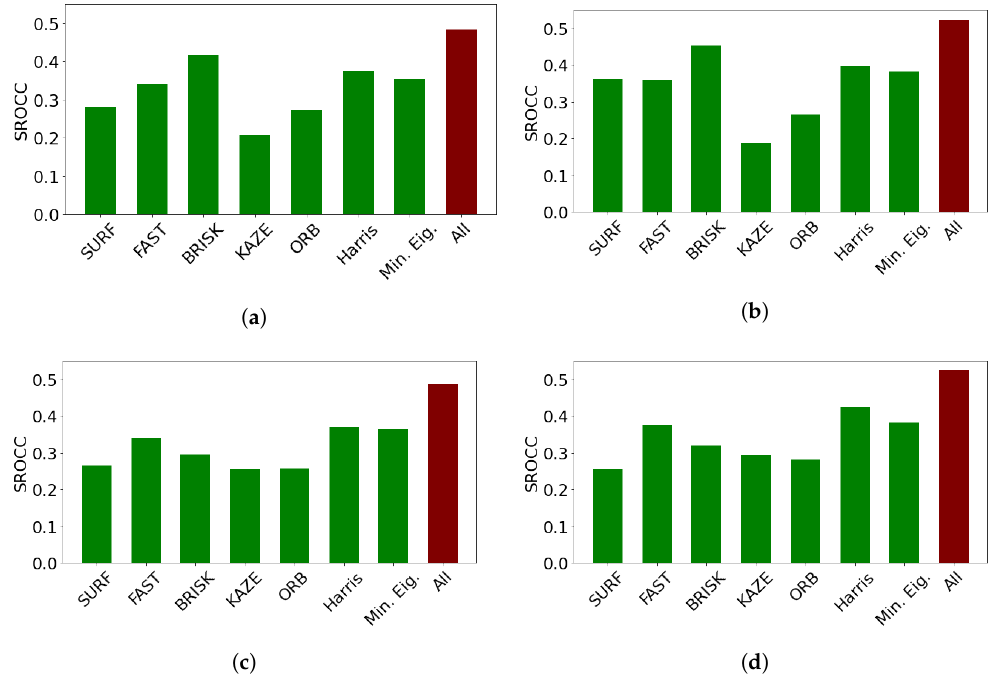
Figure 3. Comparison of the statistics of local feature descriptors as quality-aware features in CLIVE [45]. Median SROCC values were measured over 100 random train–test splits. ( a ) RGB image, SVR, ( b ) RGB image, GPR, ( c ) filtered image, SVR, ( d ) filtered image,